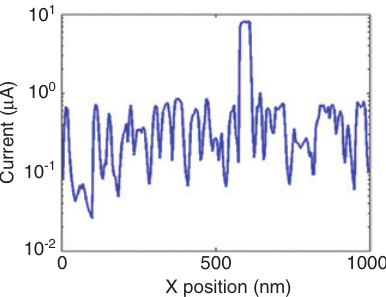
Figure 3: Variation of readout current along with tip position.